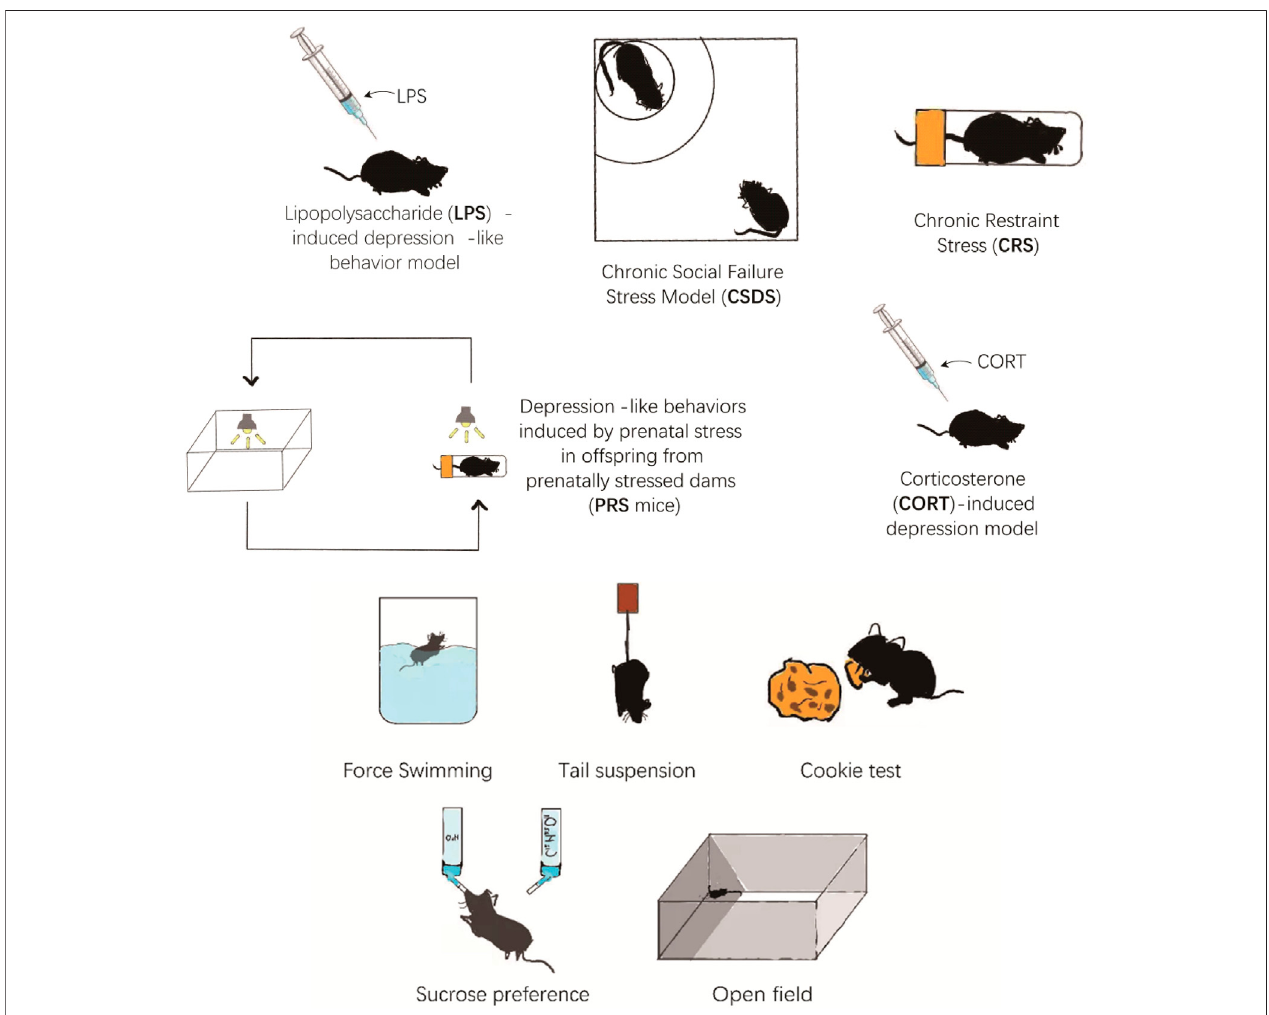
FIGURE 1 | The different animal model of